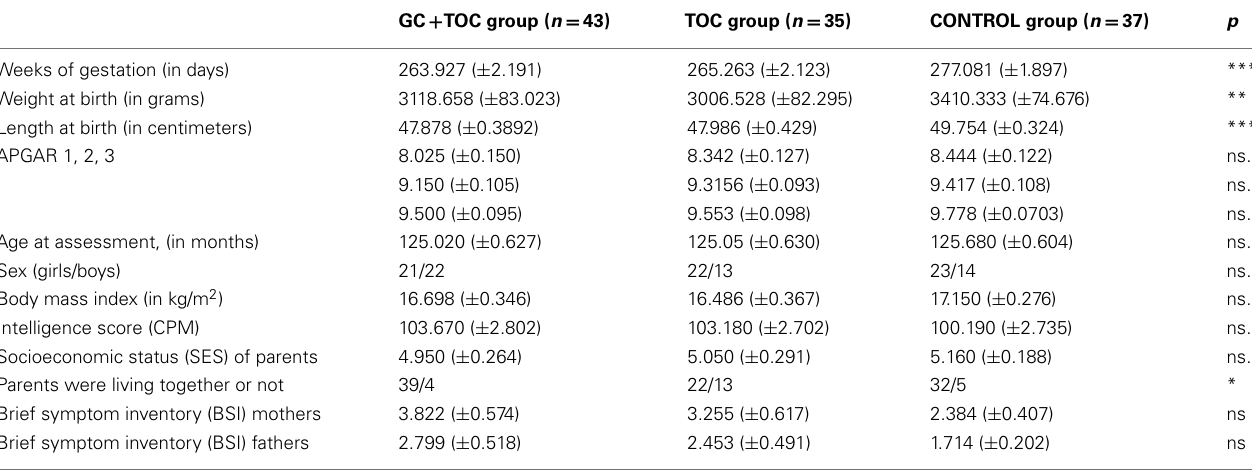
Table 1 | Sample characteristics of children with glucocorticoid and tocolytic administration ( n = 43), children in the tocolytics group ( n = 35), and children in the CONTROL group ( n = 37; means ±